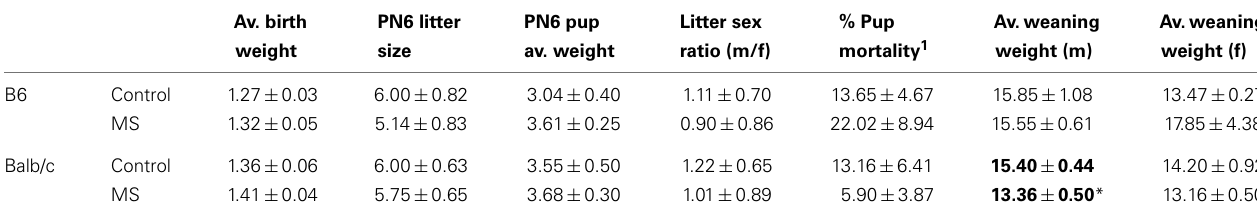
Table 3 | Reproductive outcomes (mean ± SEM) in control and MS